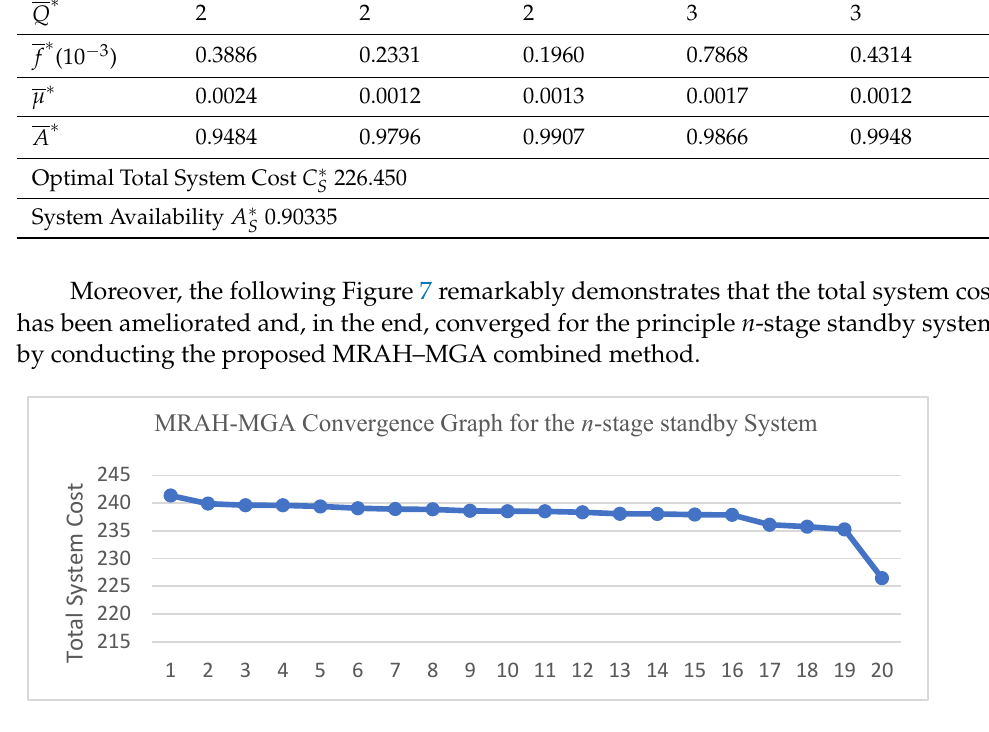
Table 15. The total system costs of 20 simulation runs obtained by ENUM–MGA for the parallel series system.